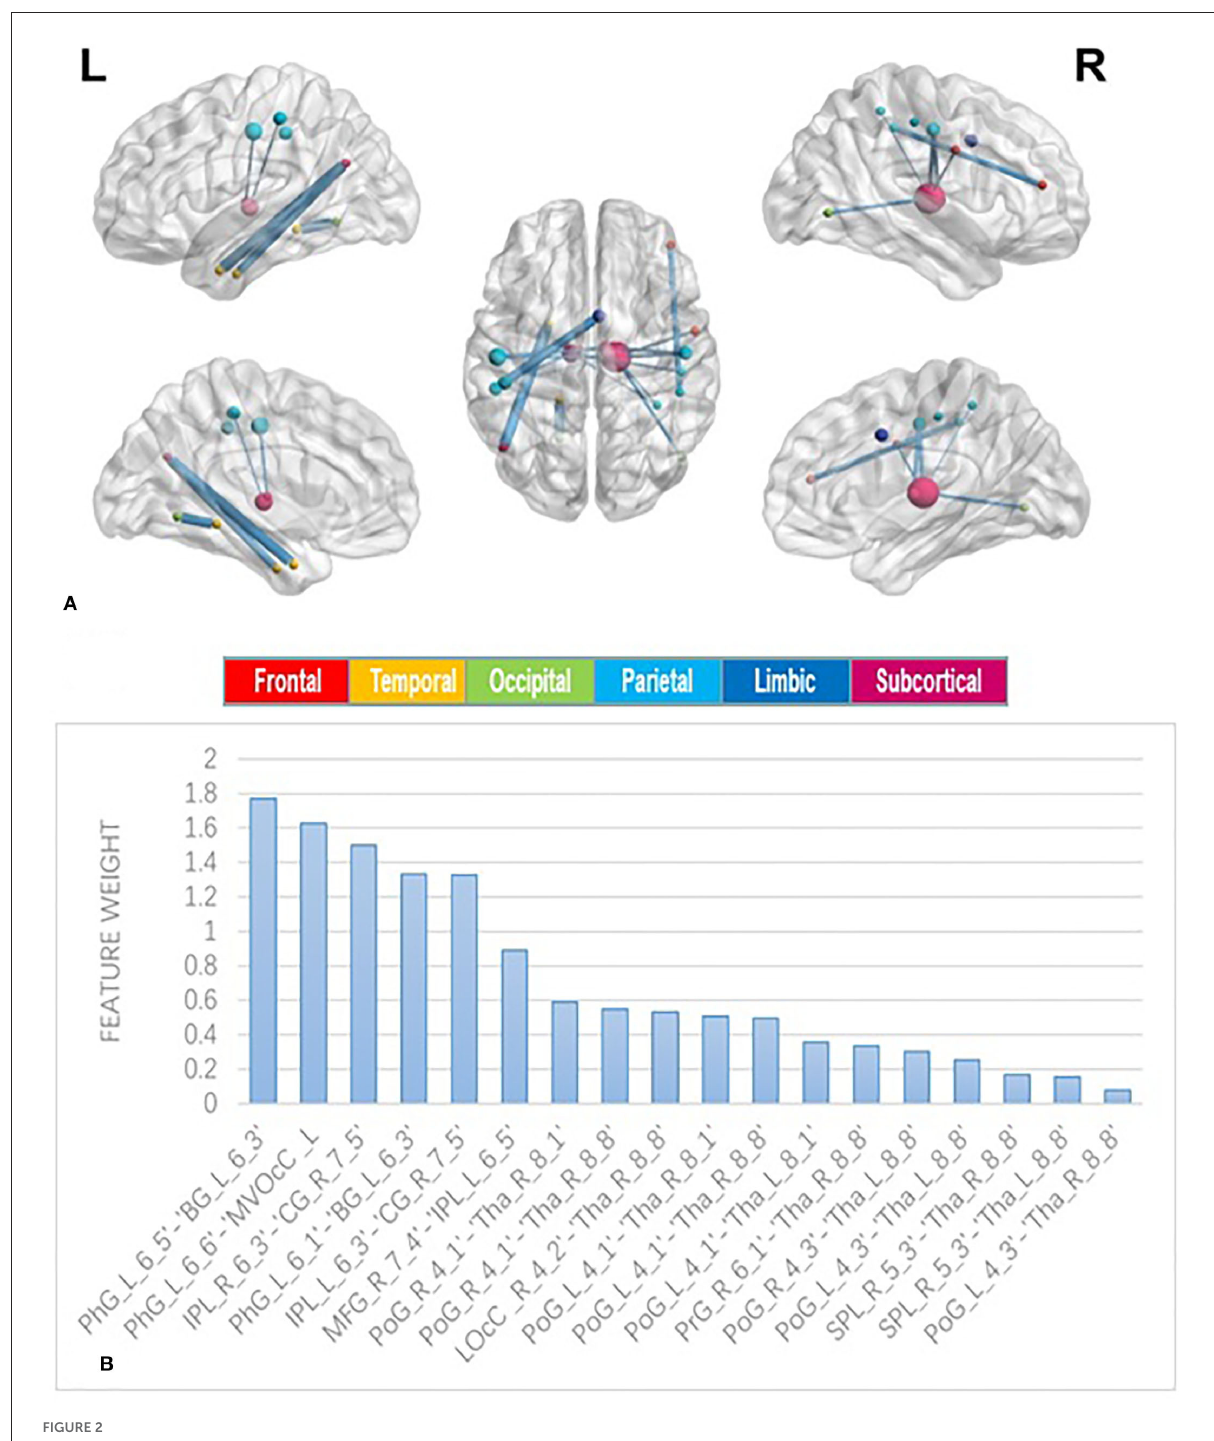
FIGURE2 Edges used as features in the classification procedure. (A) depicts the location of the 18 edges most consistently selected as relevant features to discriminate patients with methamphetamine use disorder (MUD) from healthy controls (HCs). Brain nodes are scaled according to the number of edges connected to them. Edges are scaled according to the weight value. (B) shows the rank of importance of each feature in identifying MUD in the linear support vector machine (SVM) classifier. MFG, middle frontal gyrus; PrG, precentral gyrus; PhG, parahippocampal gyrus; SPL, superior parietal lobule; IPL, inferior parietal lobule; PoG, postcentral gyrus; Tha, thalamus; BG, basal ganglia; MVOcC, medioventral occipital cortex; LOcC, lateral occipital cortex; CG, cingulate